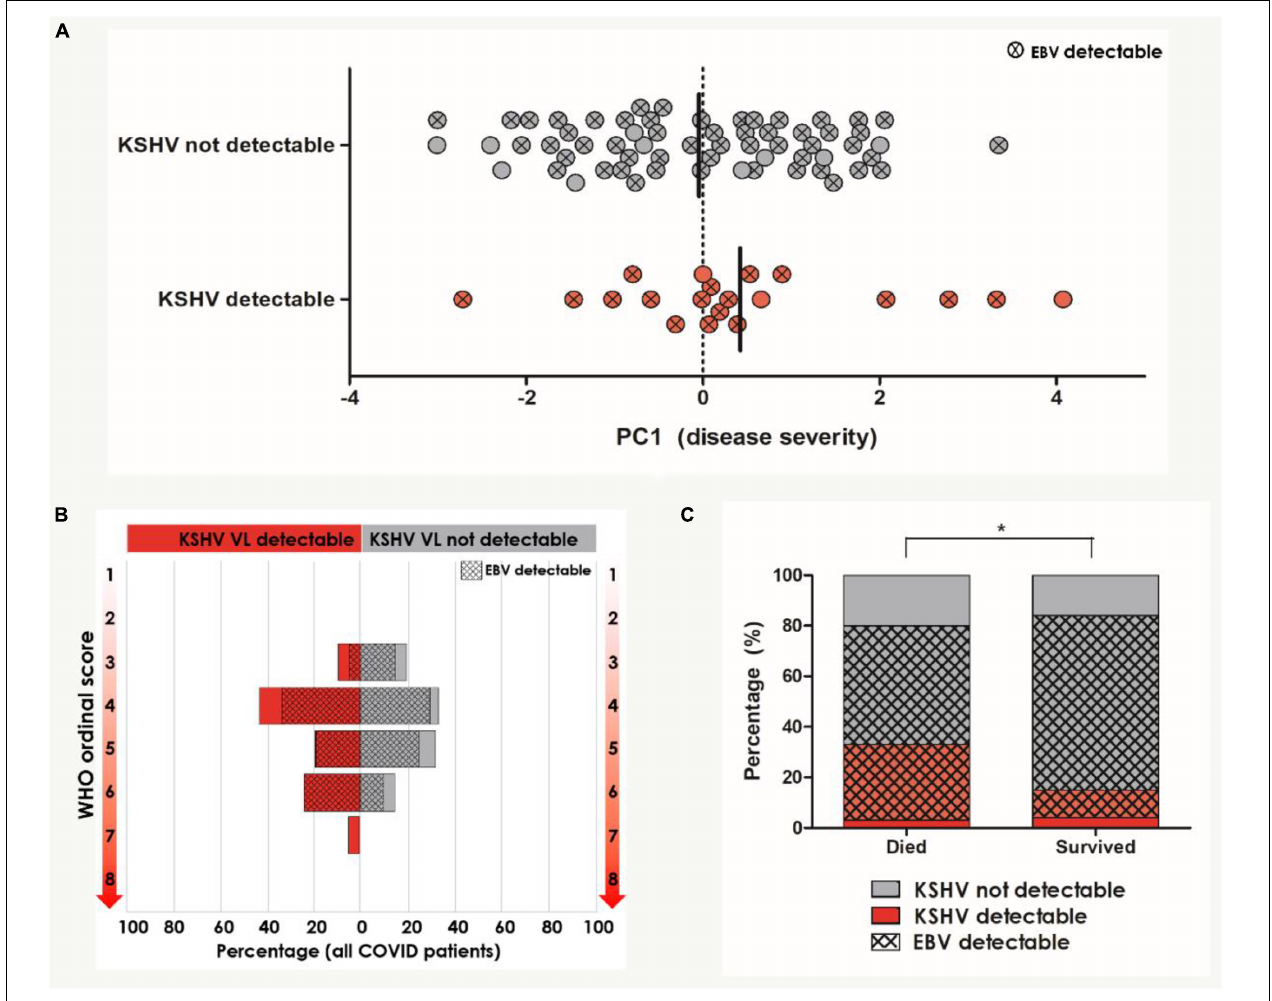
FIGURE 2 | Univariate analysis of KSHV and EBV VL detection in relation to COVID-19 severity and outcome ( n = 104). (A) PC1 severity score amongst patients with and without detectable KSHV VL in the blood. Circles indicated with an X represent patients who also have detectable EBV VL in the blood. Bars indicate median. (B) The distribution of WHO ordinal scale scores between patients with and without detectable KSHV VL. Hash pattern indicates percentages of patients with detectable EBV VL. (C) The distribution of patients with and without detectable KSHV VL between patients who died and survived. Hash pattern indicates patients with detectable EBV VL. *Indicates the statistically significant proportion of patients with detectable KSHV and EBV VL who died compared to those who survived ( p = 0.039). Participants with missing data were excluded